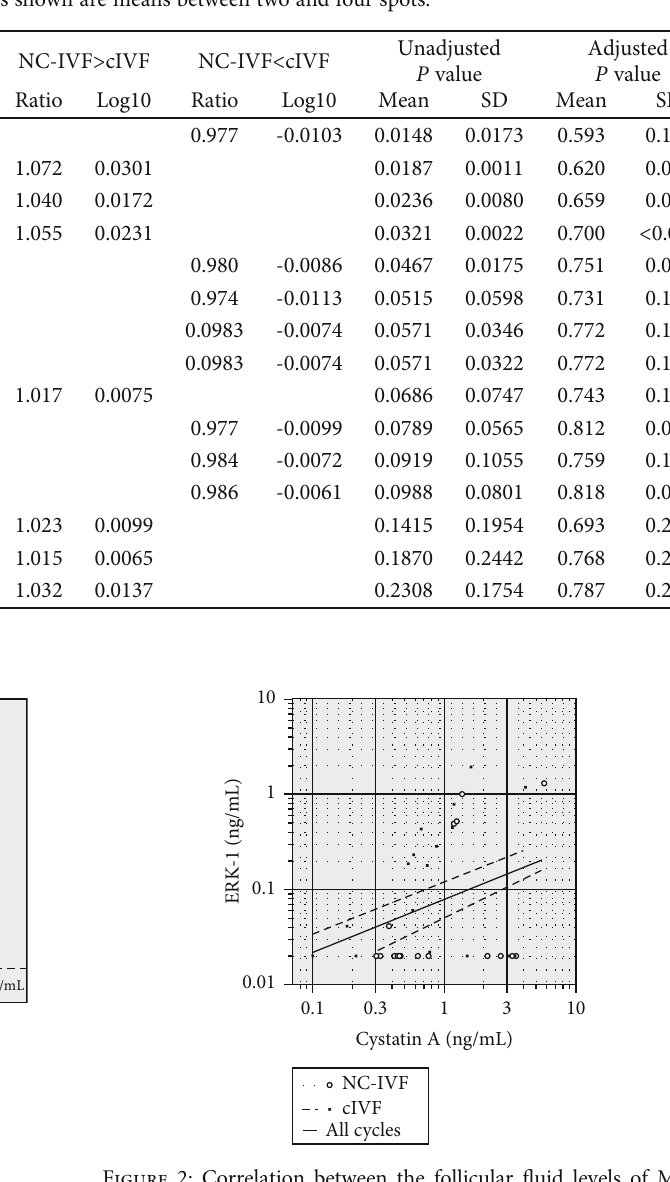
Table 2: Raw data of the fi rst 15 (nonstructural) protein markers as returned by the software and sorted by the unadjusted P value as analysed by the CSAA1 Panorama® array. The original raw table included contained another 499 lines (individual spots of proteins and all types of controls) with unadjusted P > 0 : 25 (not shown). The P values shown are means between two and four spots.